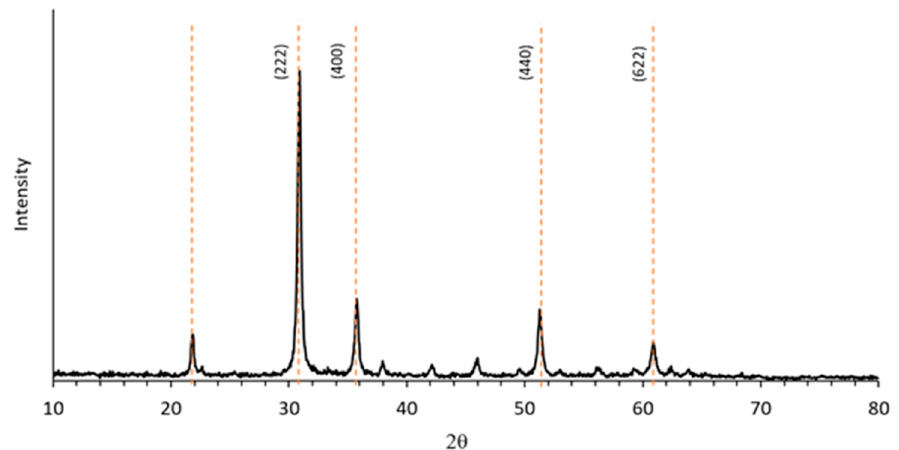
Figure 3. XR di ff ractogram of the calcined indium oxide powder. Figure 3. XR diffractogram of the calcined indium oxide powder.